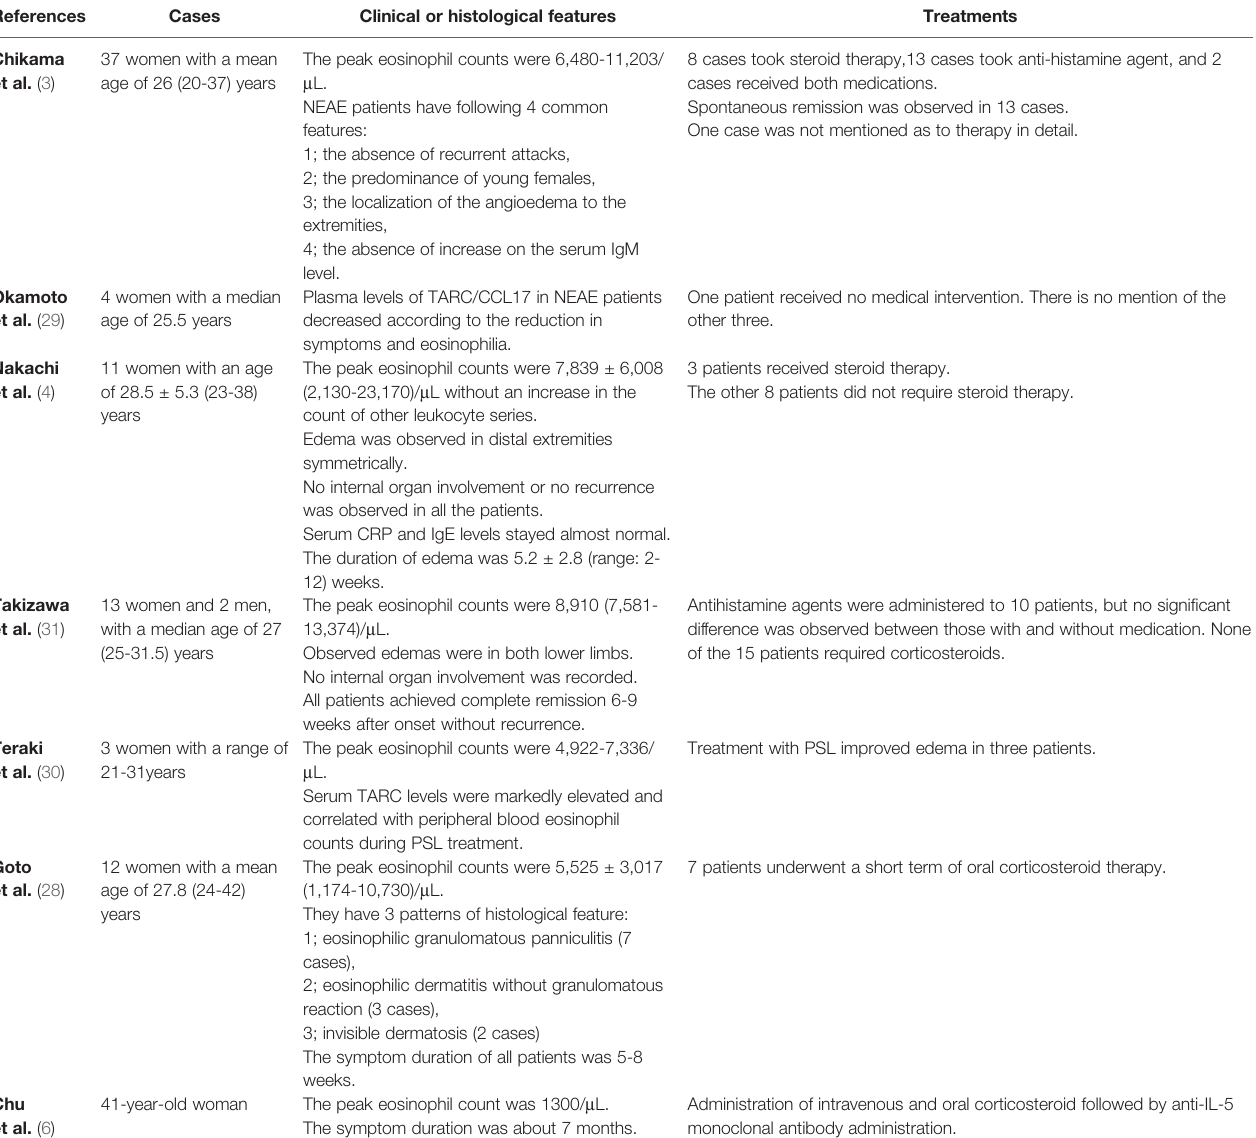
TABLE 2 | The principle fi ndings in previous studies on